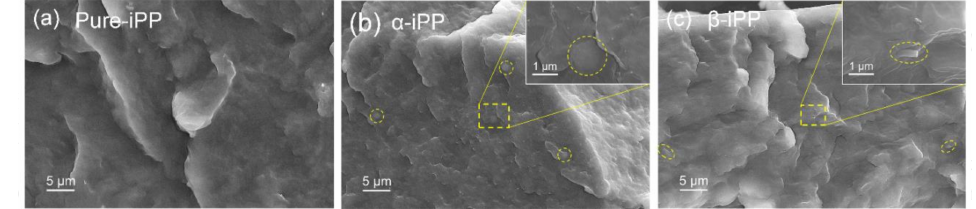
Figure 4. FESEM images of fractured faces of ( a ) Pure-iPP, ( b ) α -iPP, and ( c ) β -iPP. The inserted images with higher magnification represent a magnified area of the fracture surface.